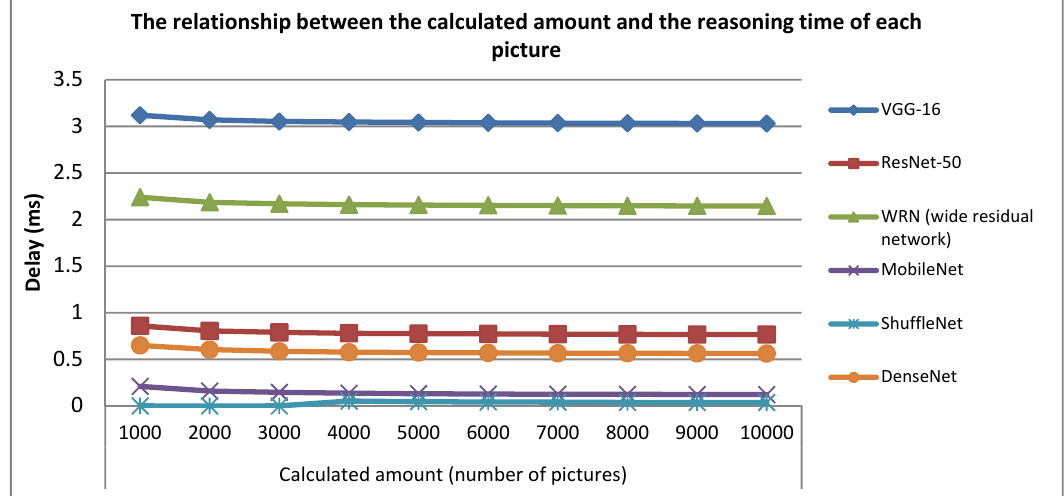
Figure 9. The relationship between the calculated amount and the reasoning time of each picture.